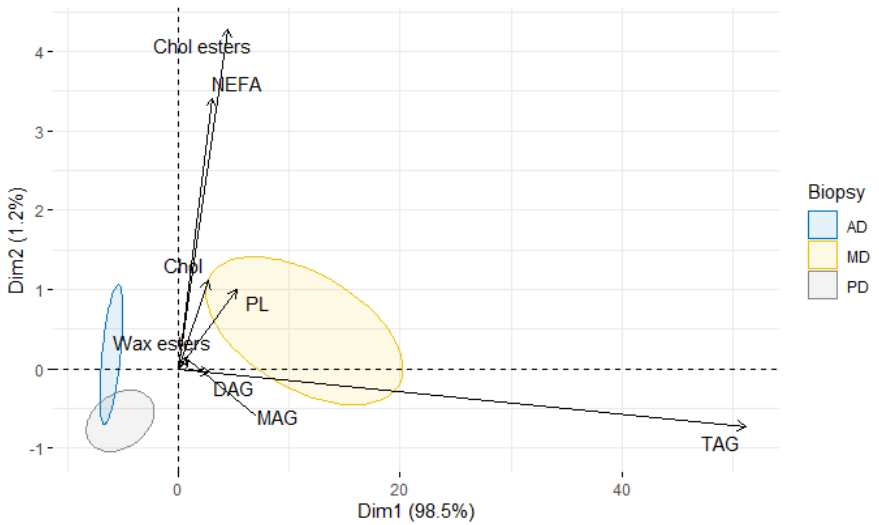
Figure 5. Principal component analysis for different biopsy regions (AD, MD, and PD) in commercial samples of beaked redfish.